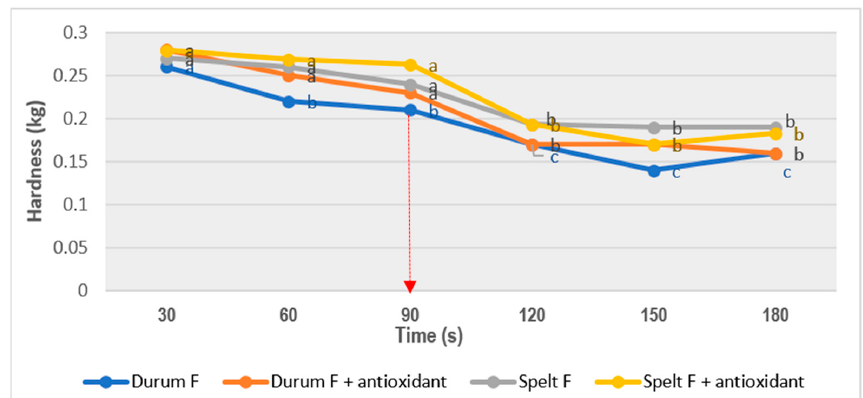
Figure 3. Optimal cooking time for both types of pasta. Distinct letters indicate significant difference ( p < 0.05) among the cooking times for each kind of pasta.